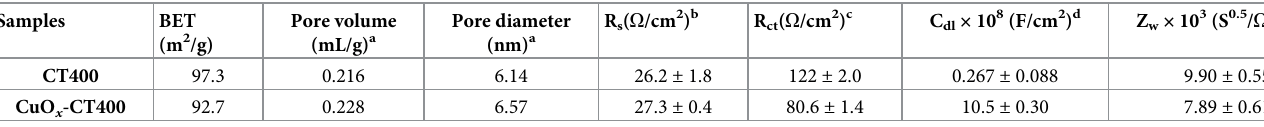
Fig 5. N 2 adsorption–desorption isotherms for CT400 (a) and CuO x -CT400 (b) and corresponding pore size distribution spectra. https://doi.org/10.1371/journal.pone.0215339.g005 Fig 6D and 6E shows the high resolution C1s spectra of CT400 and CuO evident peaks at 284.8, 286.3, and 288.7 eV are detected for CT400. The C1s peak at 284.8 eV originated from sp 2 hybridized carbon [37]. The peaks at 286.3 eV and 288.7 eV appear in sample CT400, which are attributed to the oxygen bound species C–O and Ti–O–C, respec- tively [34, 38]. The peak at 282.1eV with low intensity is close to the C 1s peak related to the binding energy between Ti and C (281.8 eV). Only small amount of C doped into the inner